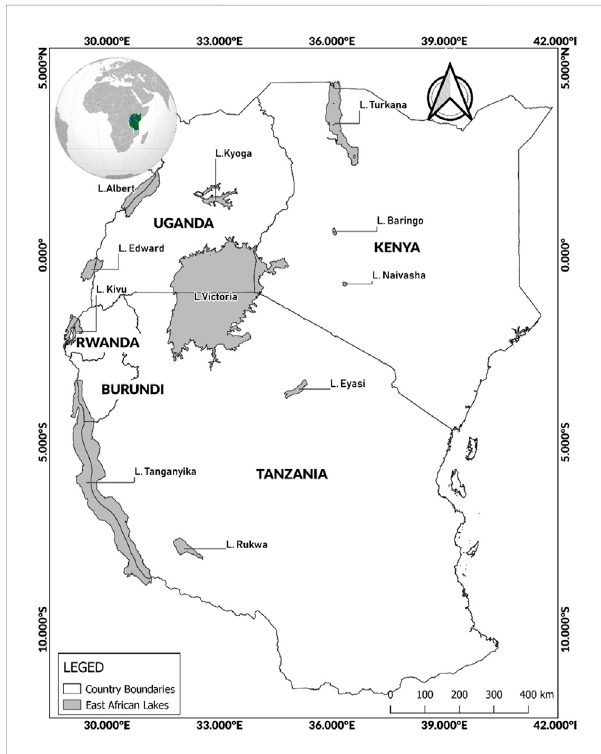
FIGURE 1 Selected major lakes in Eastern Africa that are prone to fl